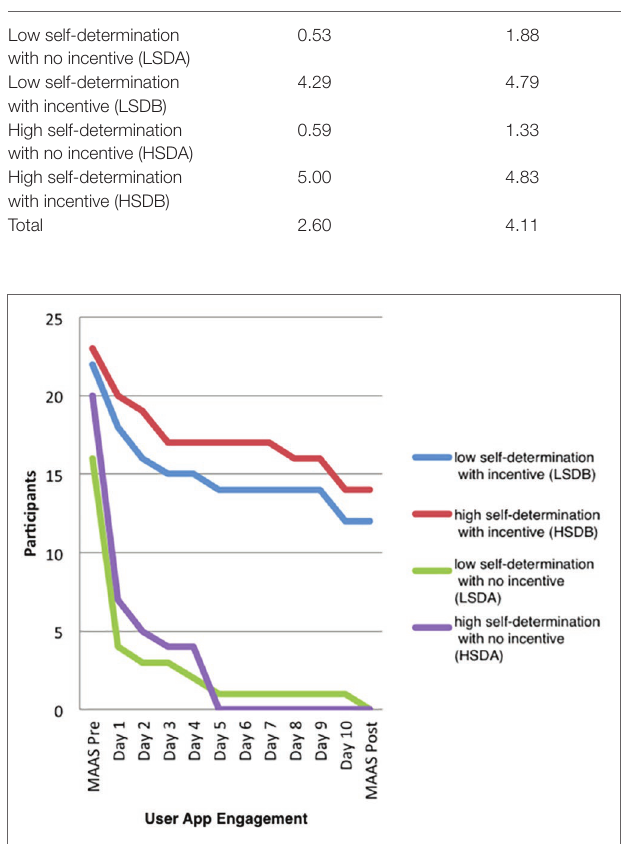
FIGURE 1 | Participation over